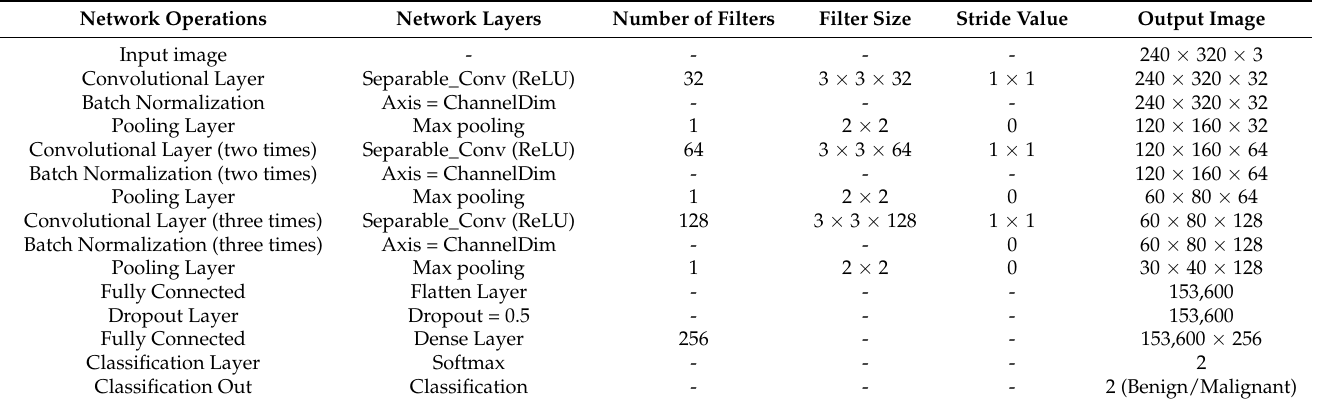
Table 2. FC-DSCNN structure used for the classification of each